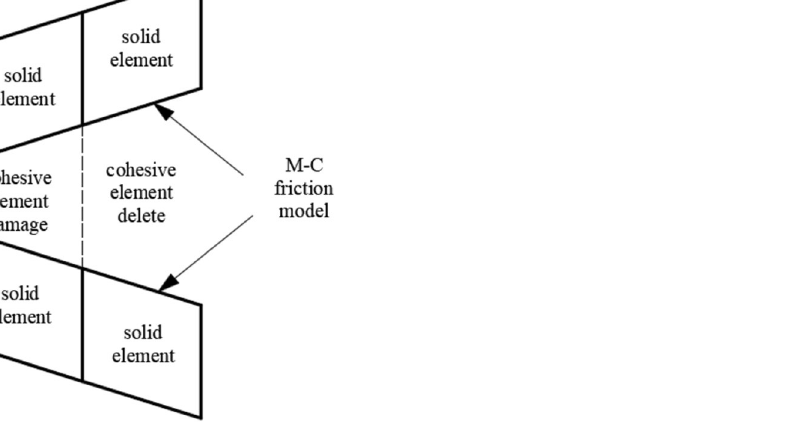
Figure 6. Crack propagation